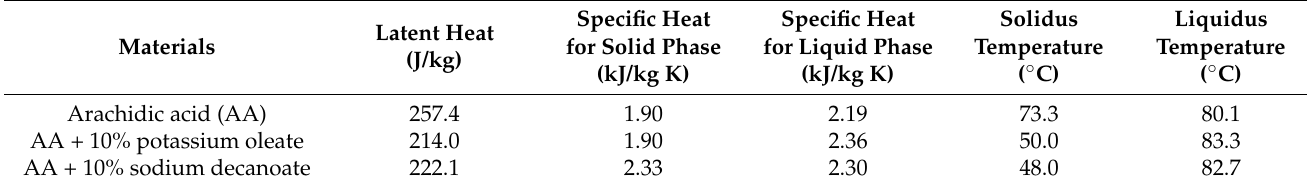
Table 2. Latent heat, specific heat and melting range of the Arachidic acid and its mixtures.